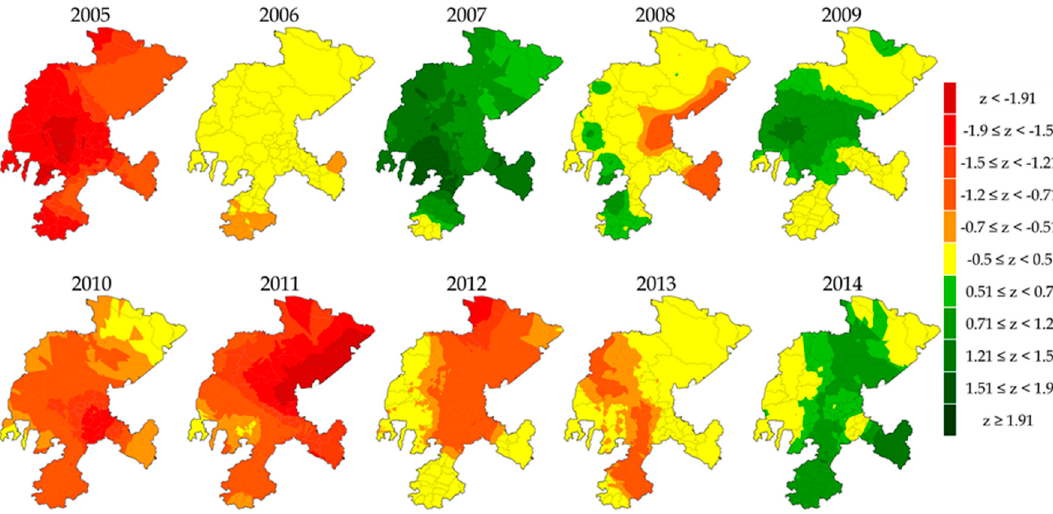
Figure 4. Three ‐ month timescale Reconnaissance Drought Index (April–June).